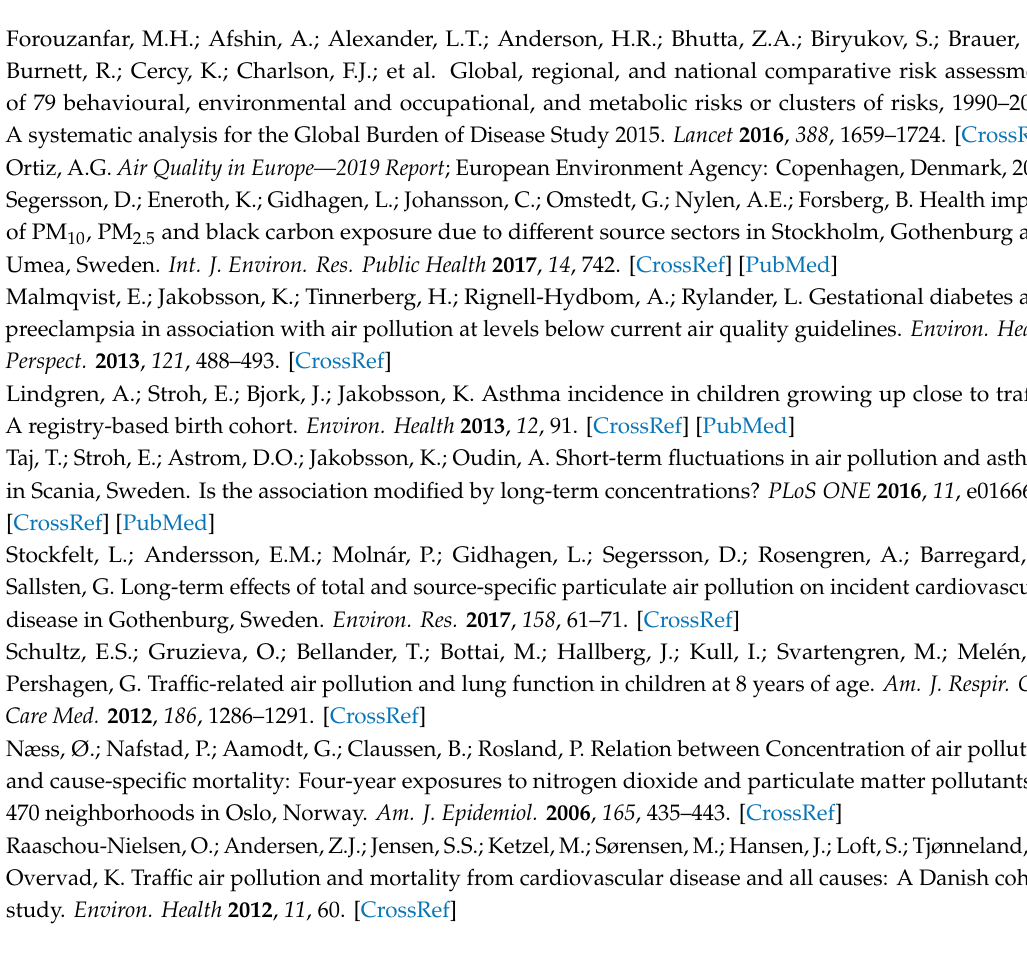
Table S1: Estimated PM2.5 exposure for the Scania population using 2011 concentrations by source. Table S2: Estimated PM2.5 ( µ g / m3) exposure for the Scania population in 2011 by source and population subgroup. Table S3: Regional exposure di ff erences of sources for “heating municipality”, harbor city and large city, local contribution and background for